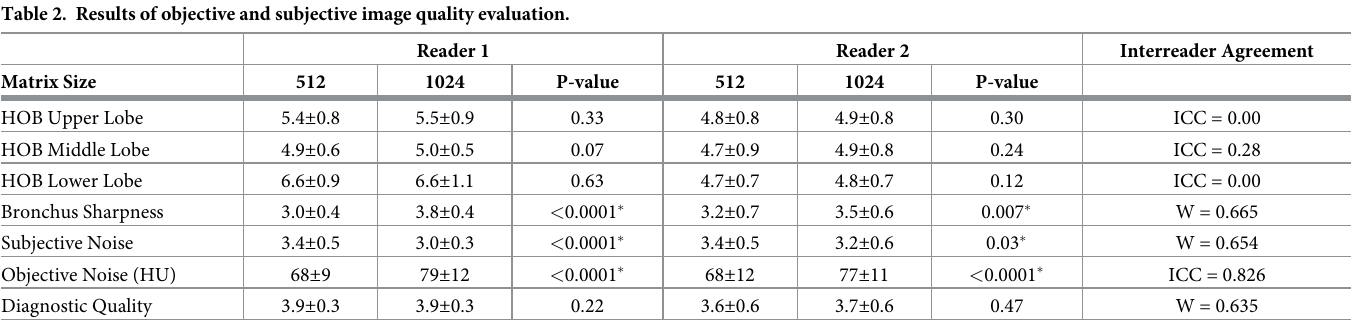
Table 2. Results of objective and subjective image quality